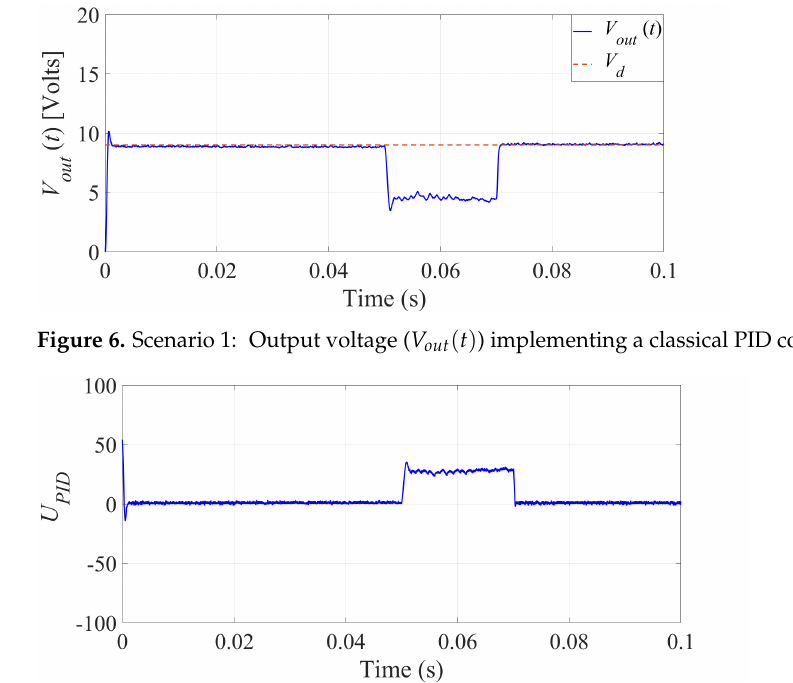
Figure 7. Scenario 1: Control input to generate the duty cycle of a PWM signal using a classical PID controller (simulation